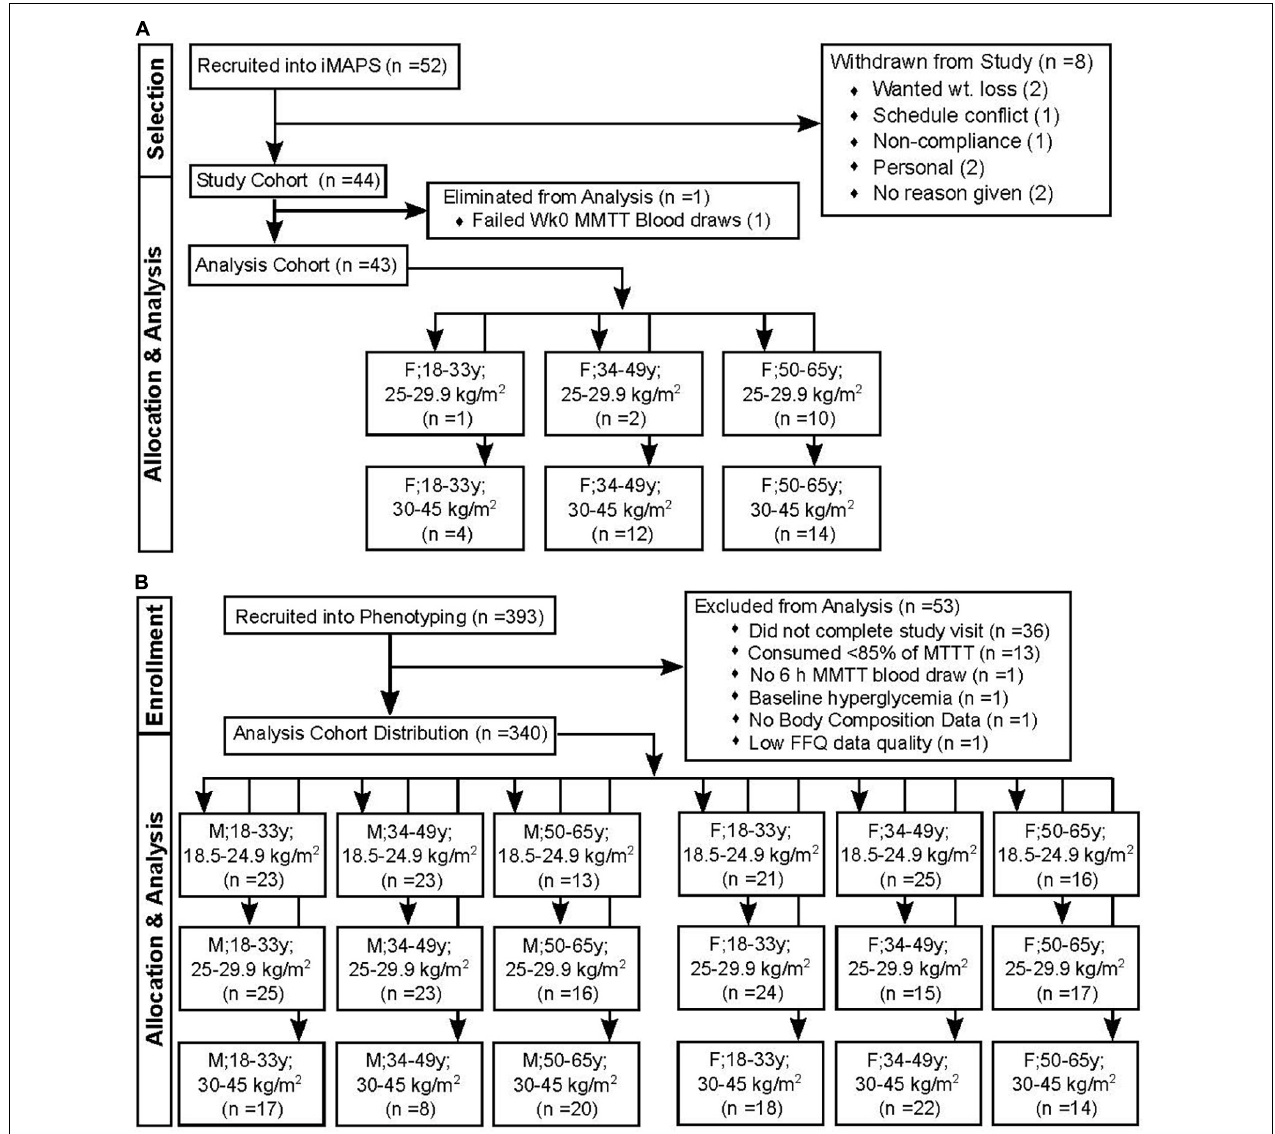
FIGURE 1 | Study recruitment and data restrictions for the mixed macronutrient tolerance test (MMTT) analysis. (A) The individual Metabolism and Physiological Signatures Study (iMAPS) recruited 52 female (F) individuals with BMIs in the overweight to the obese range. Of these, 44 completed the entire 8-week intervention. A single individual was lost to the triglyceride analysis due to difficulty in blood collection (B) The WHNRC nutritional phenotyping study recruited 393 male (M) and F participants with attempts to balance into 3 age and BMI ranges. Of these, 340 were retained for